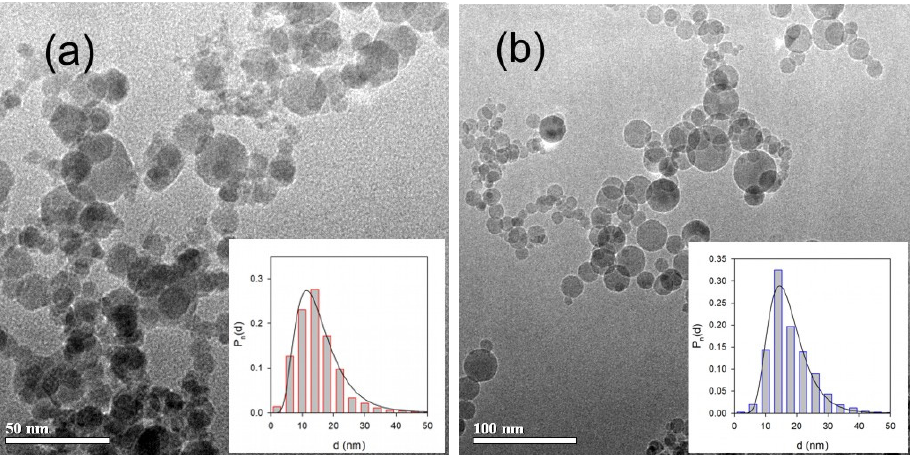
Figure 1. TEM images of LTE MNPs ( a ) and ANPs ( b ). Inserts: histograms of PSDs; lines give fitting of PSD with lognormal distribution function.